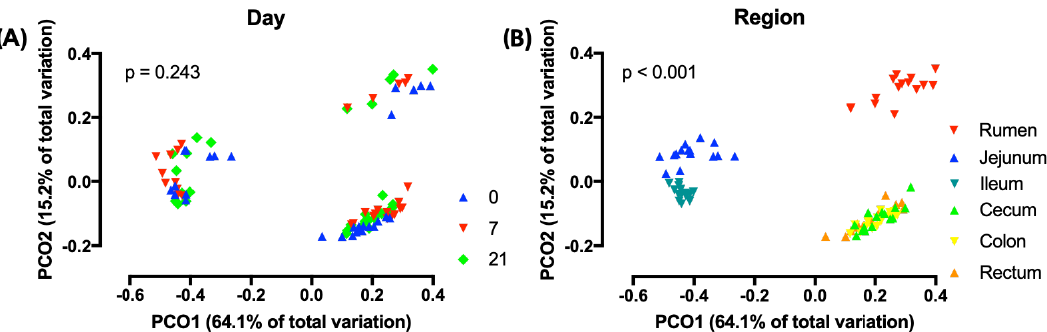
Figure 3. Principal coordinate analyses (PCoA) of weighted UniFrac distances of ( A ) treatments across regions of the digestive tract and ( B ) regions of the digestive tract across treatments. 0 = no grain feeding, 7 = moderate grain feeding for 7 d, 21 = moderate grain feeding for 21 d. Effect of day across regions is not significant ( p = 0.243) Effect of region across treatment is significant ( p < 0.001).